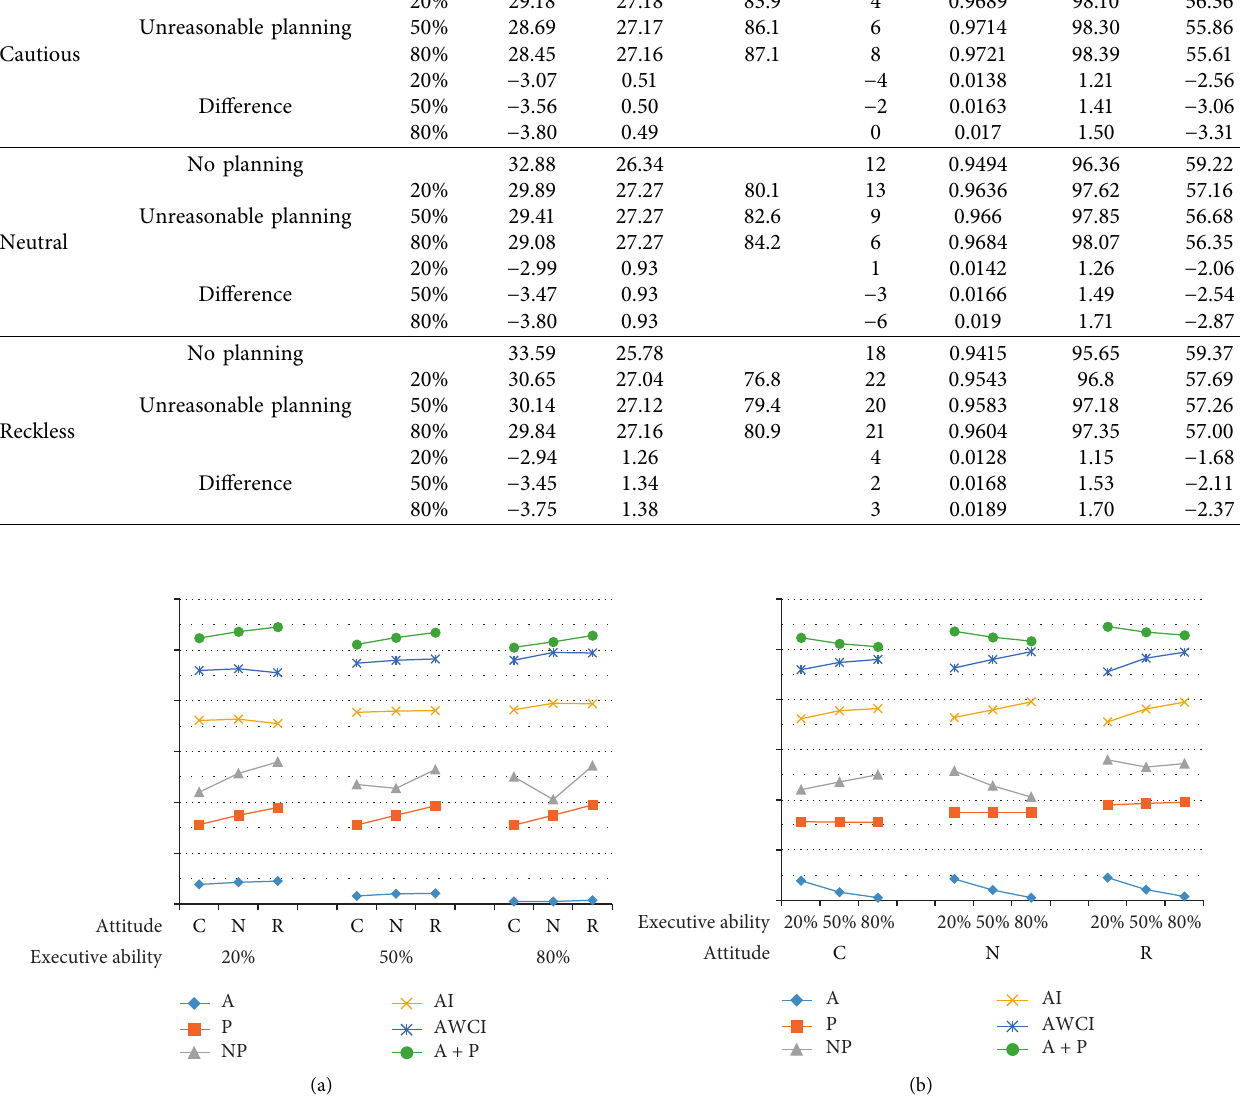
Figure 7: Index comparison between the situations of unreasonable planning and no planning. Notes: dotted line represents 0 value line, underneath the line indicates that the value in the situation of unreasonable planning is smaller than that in the situation of no planning, and otherwise represents bigger.